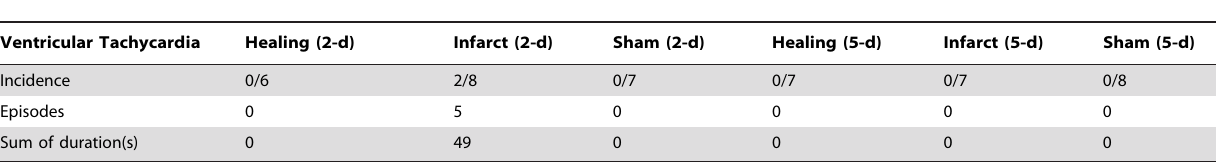
Table 4. Comparison of episodes of ventricular tachycardia within 10 min of bolus injection of epinephrine.